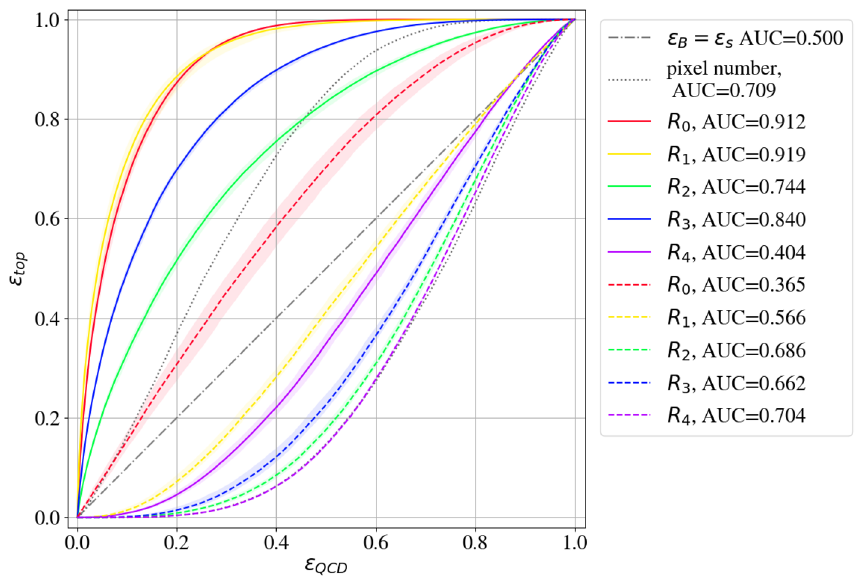
Figure 15 . ROC curves of the direct (solid) and inverse (dashed) taggers using the different intensity mappings R 0 to R 4 . The dotted lines represent the ROC curves of the two taggers based on the number of the non-zero pixels in the